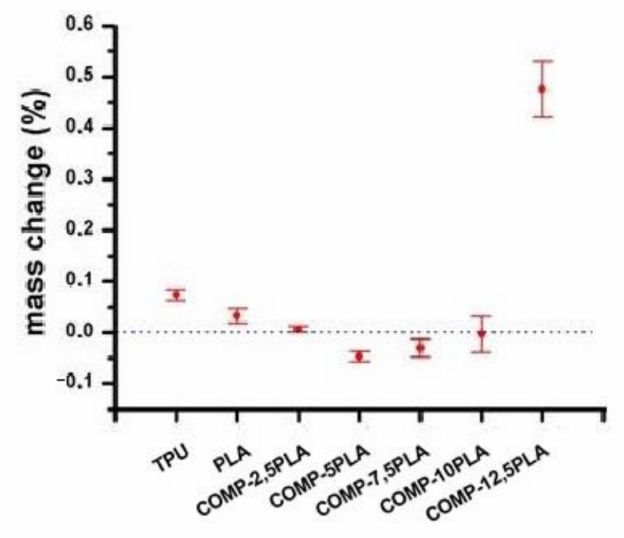
Figure 8. Sample’s mass change in calcification